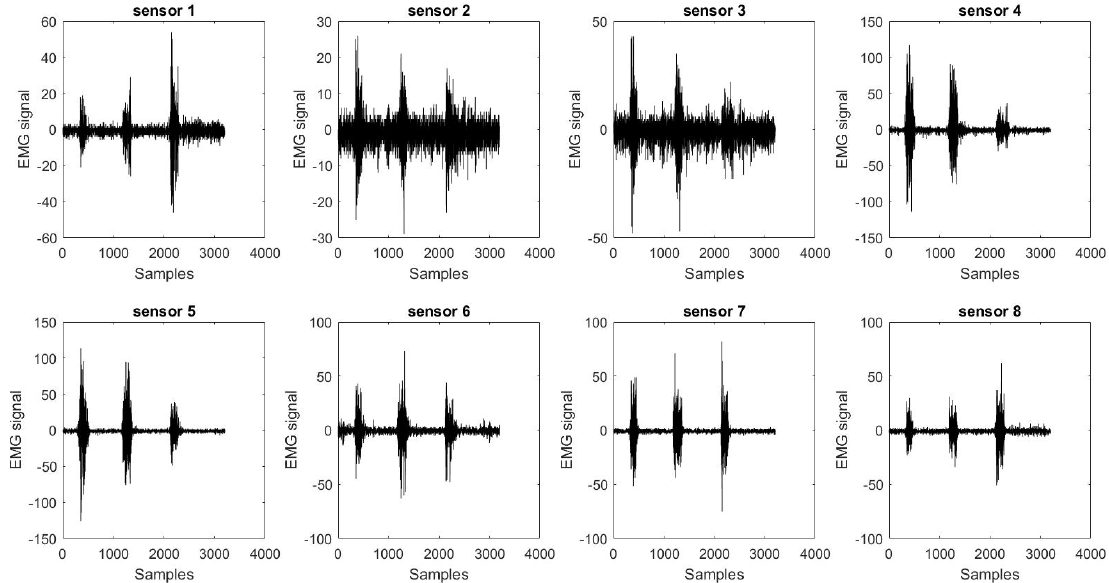
Figure 3. An example of the eight electromyography (EMG) sensors’ raw data collected by the Myo